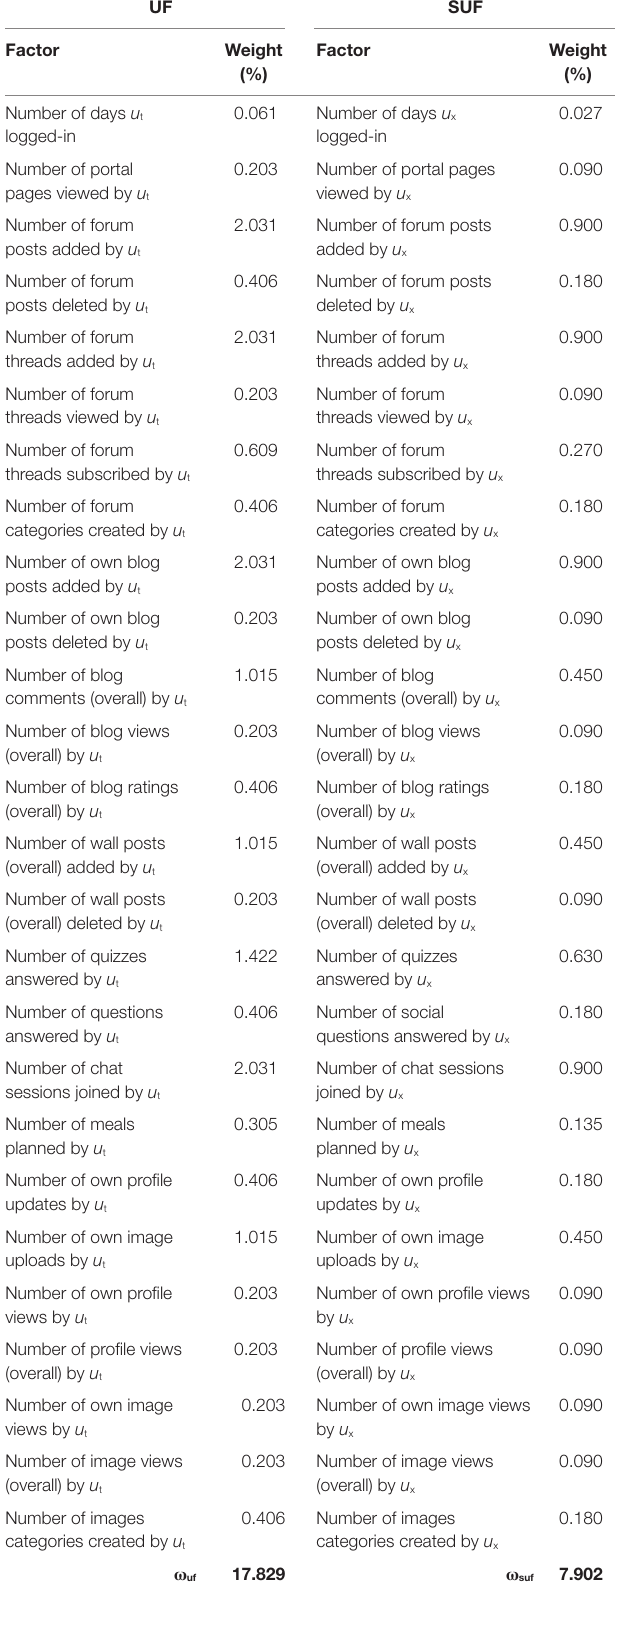
TaBle 1 | Target and subject user factors and their